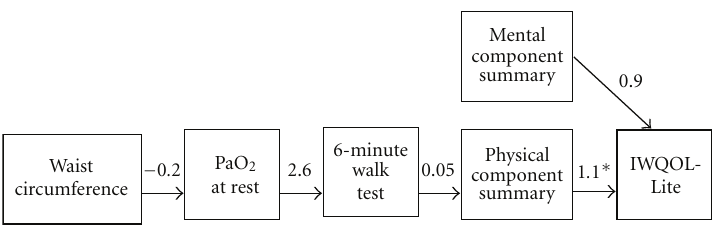
Figure 1: The path to quality of life for morbidly obese men and women. The coe ffi cients correspond to the regression coe ffi cient. Table 2: Univariate linear regression models.